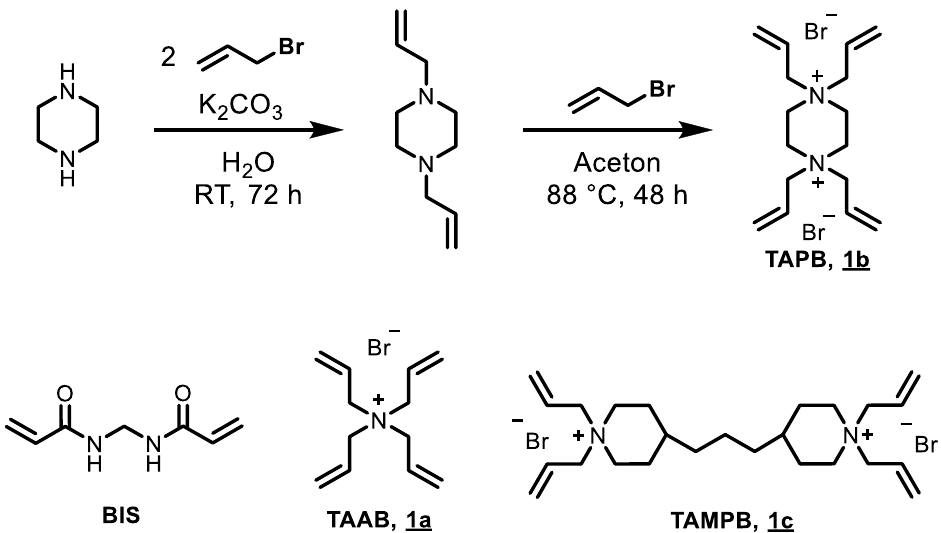
Figure 1. Top: Outline of the two-step synthesis of 1b, c using 1b as example; bottom: structures of the other three cross-linkers used in this study.